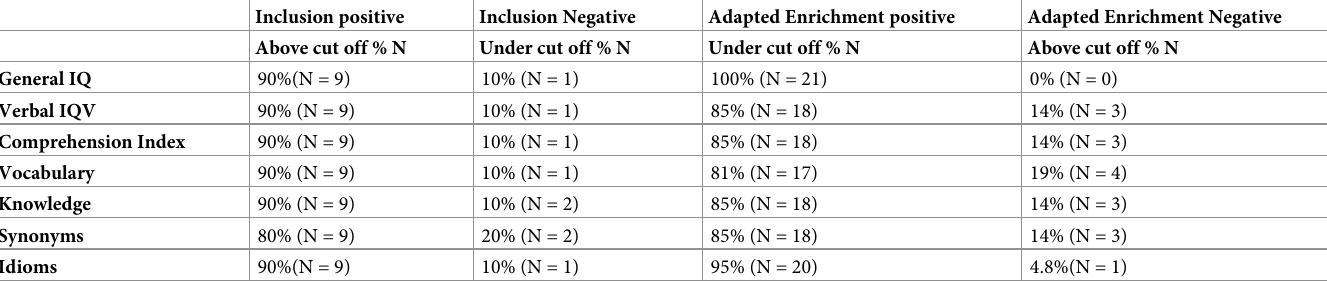
Table 5. Percentage above and below the ROC cutoff point in the full integration ( N = 10) versus the adapted enrichment ( N = 21)